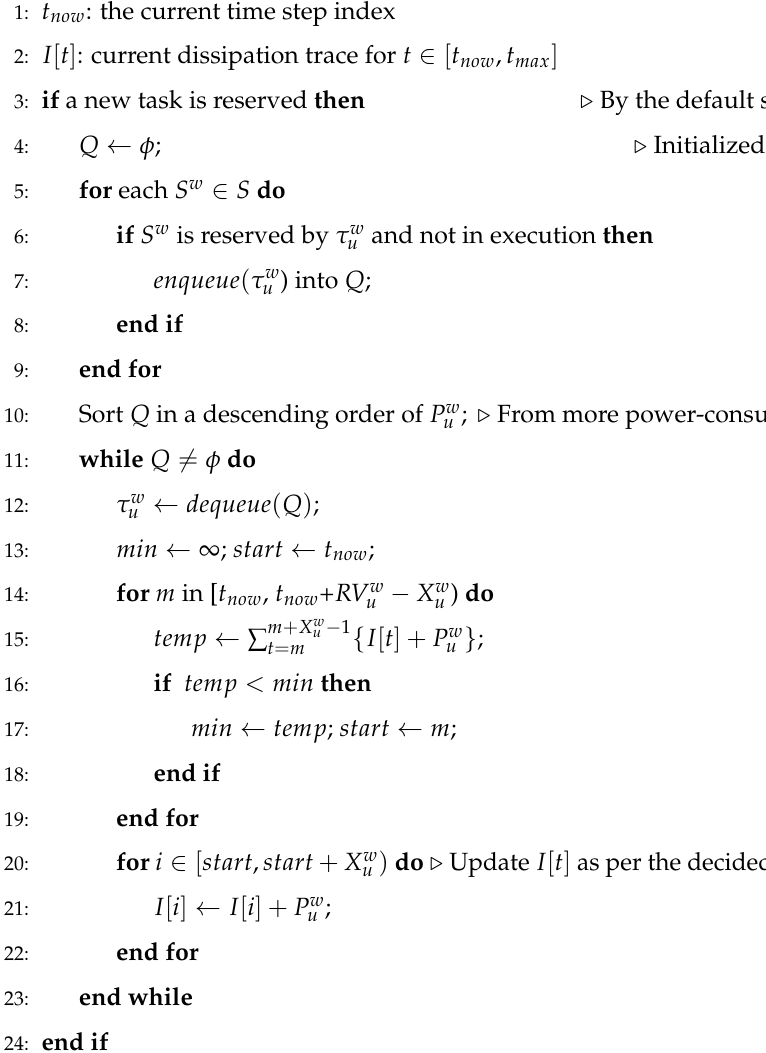
Algorithm 2 Run time scheduling of the reserved tasks in the RET framework